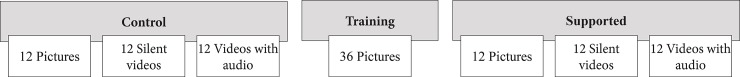
Study design.The experiment was divided into a control, training, and supported phase, each with 36 stimuli consisting of pictures, silent videos and videos with audio.